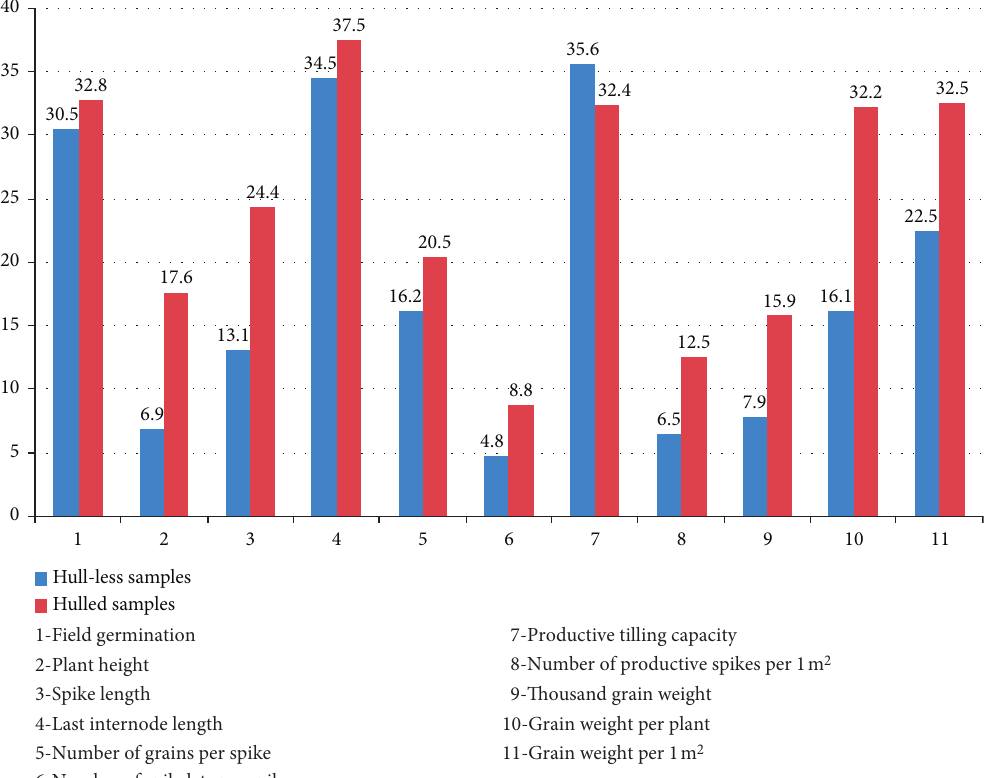
Figure 2: Variability of commercial-biological traits in the conditions of the Aral Sea region of Kazakhstan